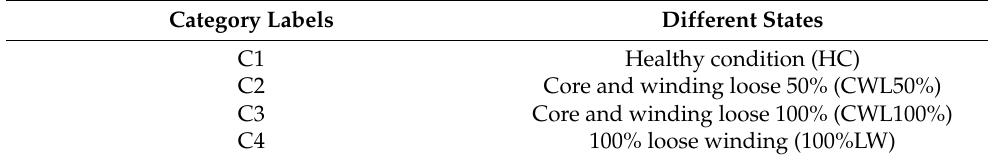
Figure 16. 20 kV HVSR experimental platform. Table 3. 20 kV HVSR fault types.